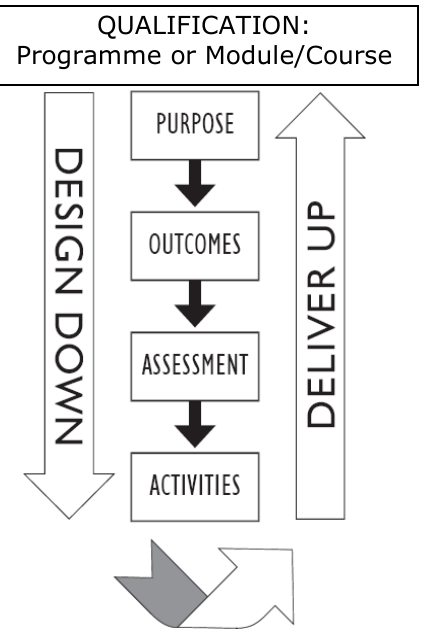
Figure 3 . The “Design Down → Deliver Up” approach (Source: Adapted from SAQA, 2005, p.6) Starting from defining the purpose of the learning programme, the methodology moves down